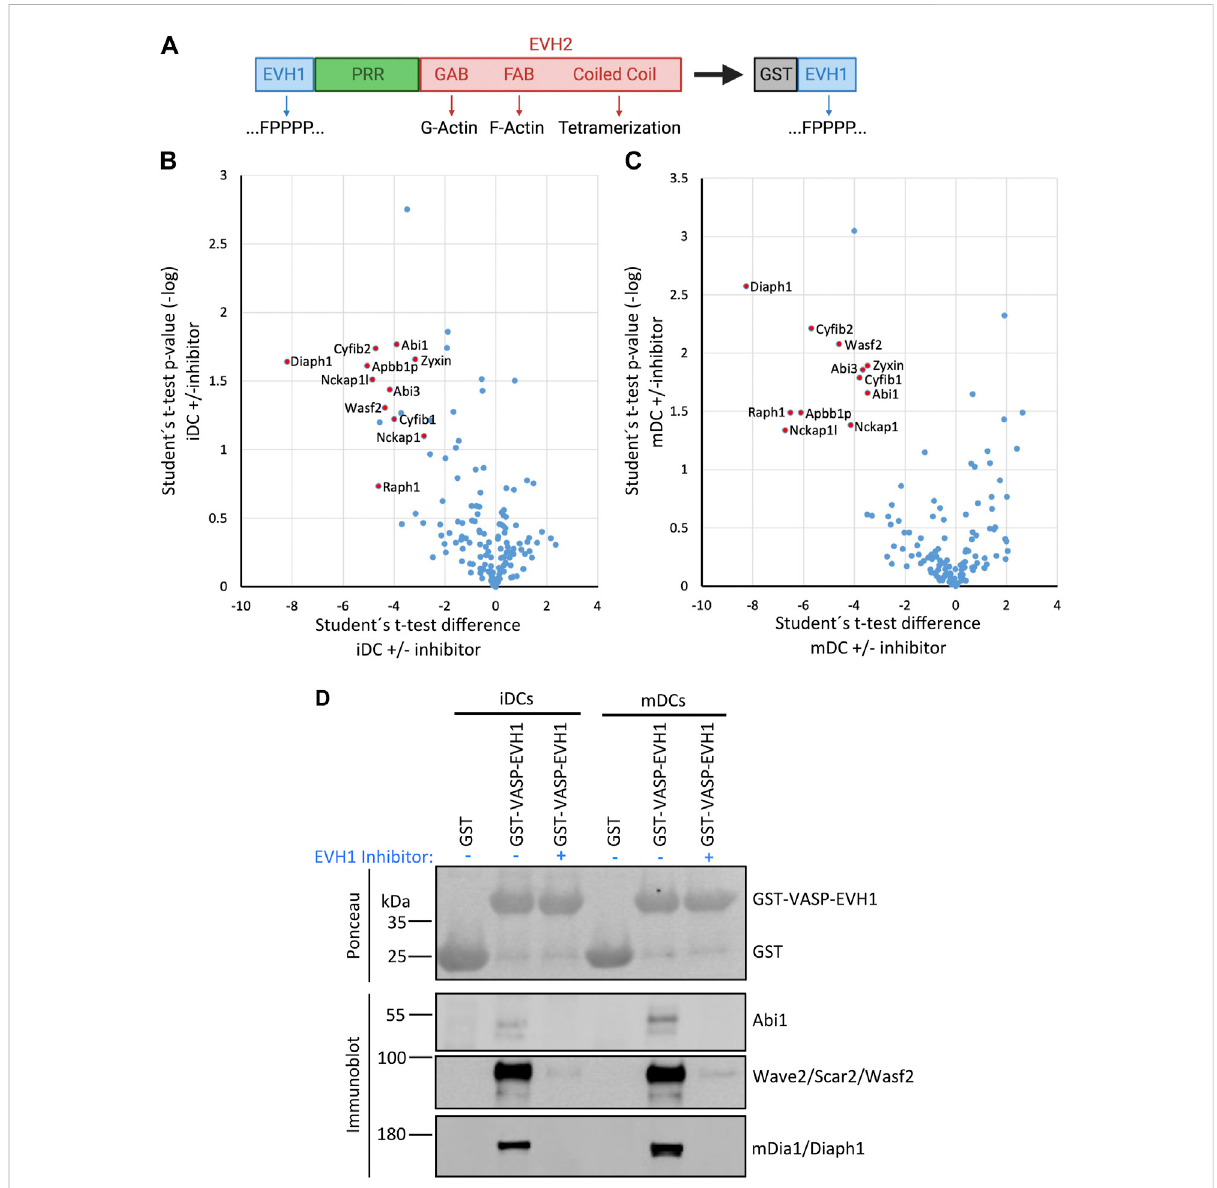
The VASP-EVH1 domain interacts with Wave2 and mDia1 in DCs. (A) Domain structure of Ena/VASP proteins and derived GST-fusion protein. EVH1,Ena/VASPhomology1domain;EVH2,Ena/VASPhomology2domain;PRR,Proline-richregion;GAB,G-actinbindingsite;FAB,F-actinbinding site; GST: Glutathione S-transferase; FPPPP, Pro-rich motif recognized by EVH1 domain. (B – D) Recombinant GST-VASP-EVH1 and GST as control were puri fi ed from bacteria with GST-beads and incubated with detergent-extracted lysate of immature or mature DCs in the presence or absenceofanEVH1-speci fi cinhibitor.Afterthoroughwashing,proteinswereelutedandanalyzedbymassspectrometry (B,C) orbyimmunoblotting with the indicated antibodies (D) . Volcano plots illustrate the inhibitor-sensitive hits obtained by mass spectrometry for iDCs (B) and mDCs (C) . (D) Immunoblotting con fi rms that Abi1 and Wave2 (as representatives of the WRC) and mDia1 from iDCs and mDCs show speci fi c binding to the EVH1 domain of VASP which is inhibited by the EVH1 domain-speci fi c